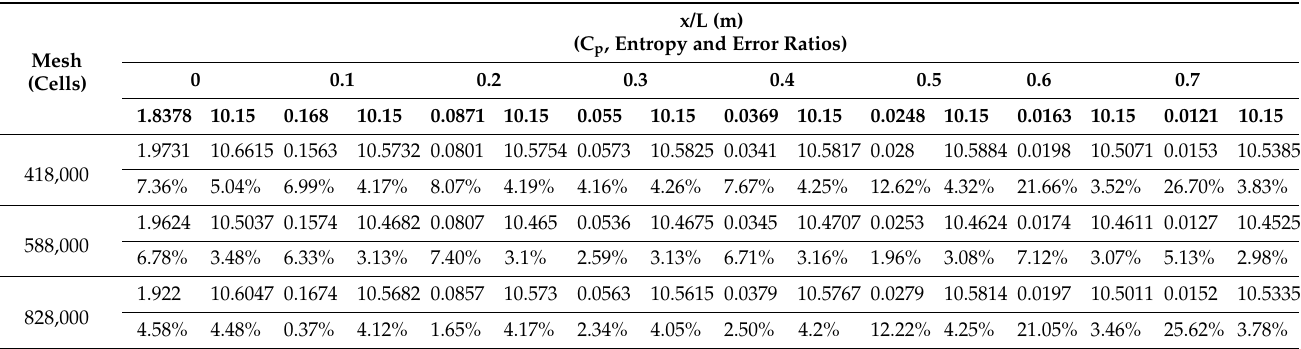
Table 5. Grid independency study of three levels of different mesh with error ratios for pressure coefficient and entropy at a far-field distance is 16 m.